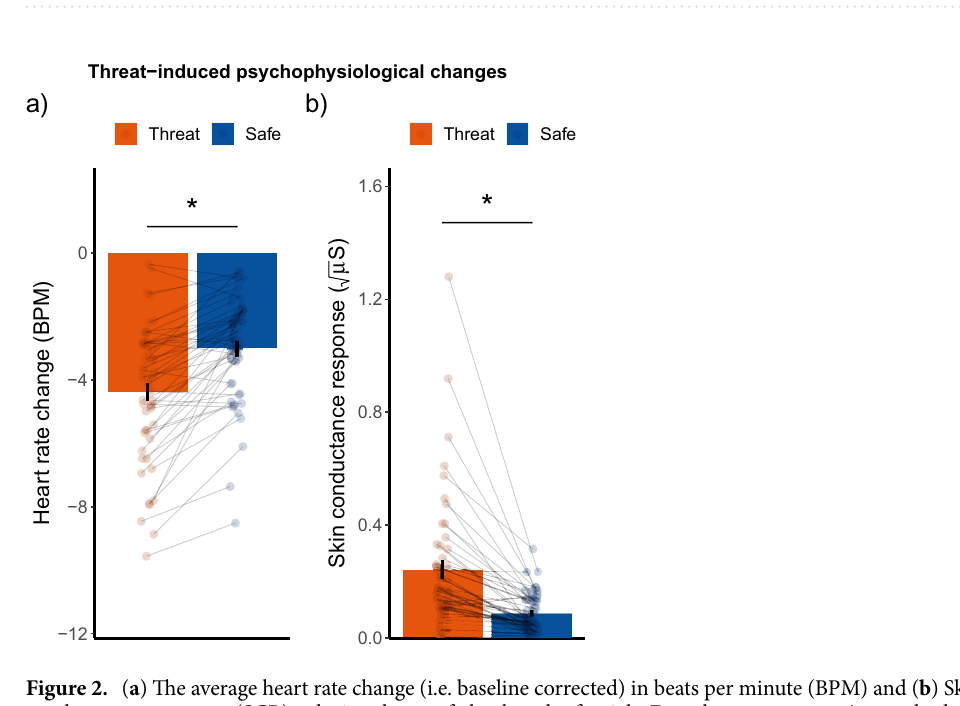
Figure 1. ( a ) Trial structure during the experimental blocks ( b ) orange and blue fixation colour indicating the threat-of-shock or safe condition (counterbalanced across subjects) ( c ) structure of the target- frequency manipulation, in black is the occurrence of the target and grey the lure.